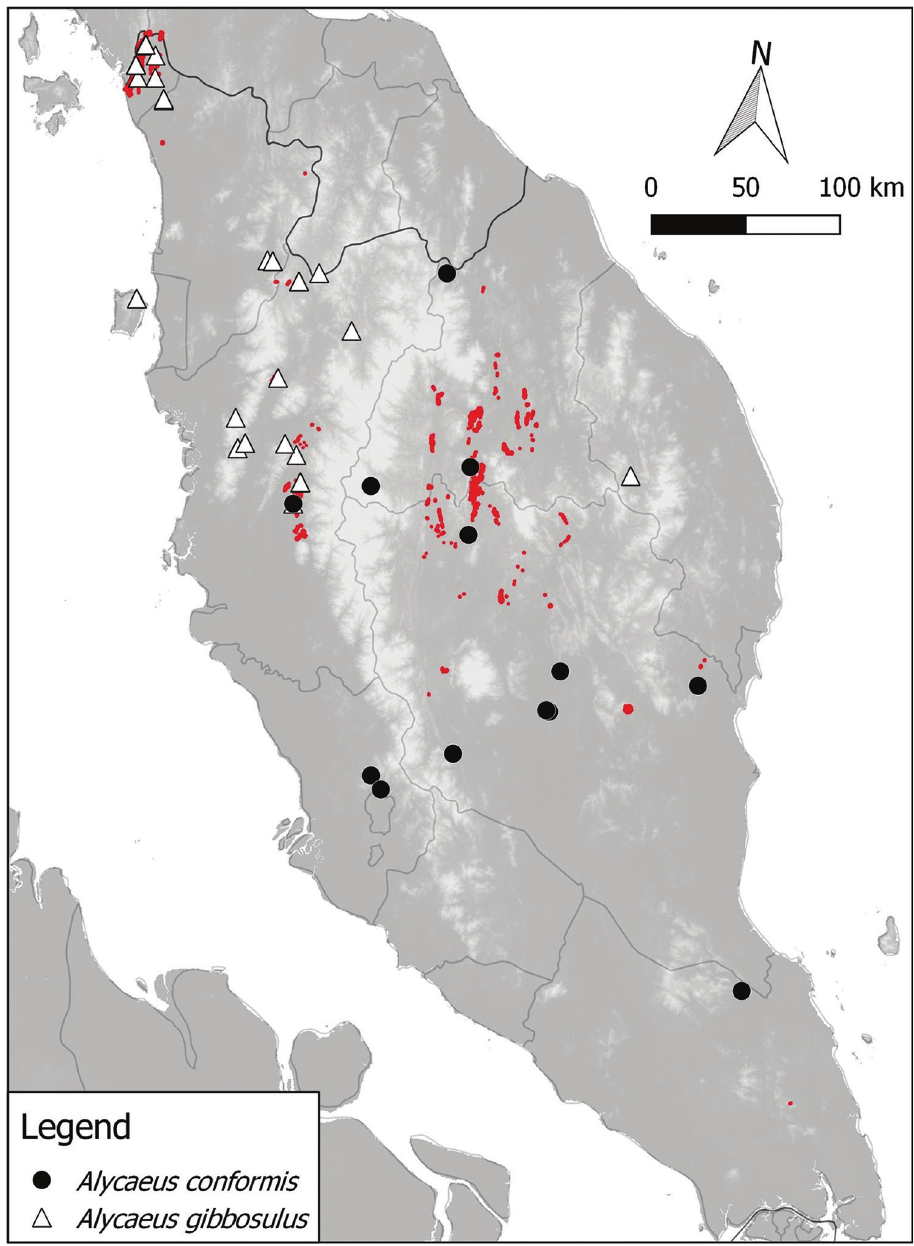
Figure 5. Distribution of 2 Alycaeus species in Peninsular Malaysia based on materials examined. Note the red areas are limestone karsts (derived from Liew et al.